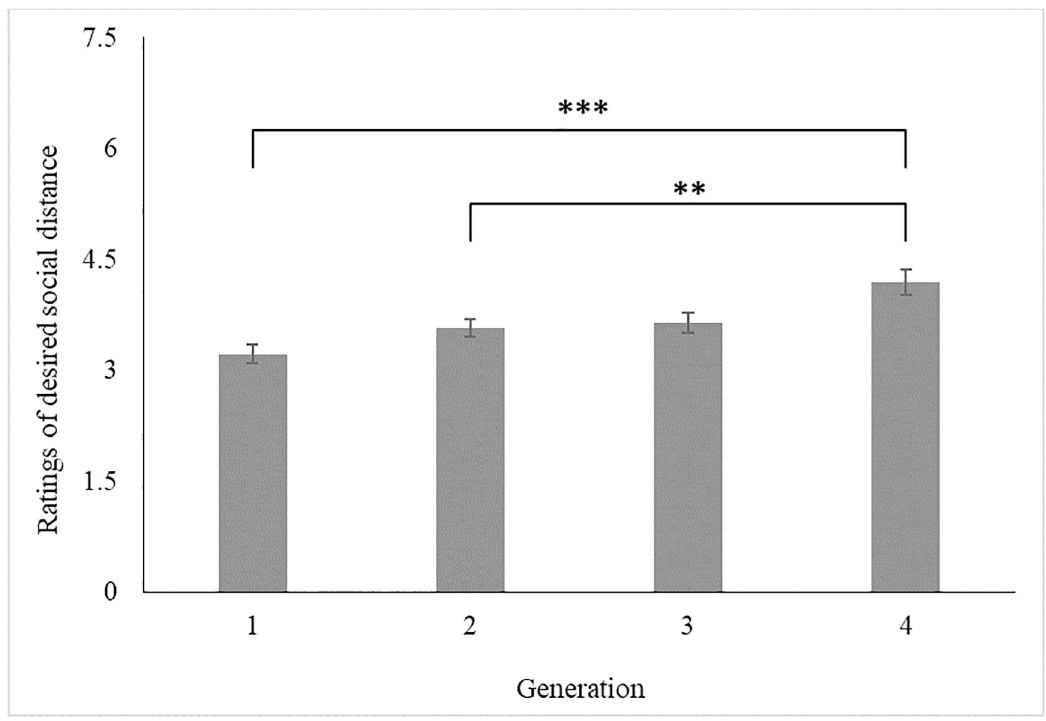
Fig 4. The effect of Generation on ratings of desired social distance (with SE mean ). Note : ��� p < .005; �� p < .030; � p < .050. Higher scores are indicative of lower desired social distance.